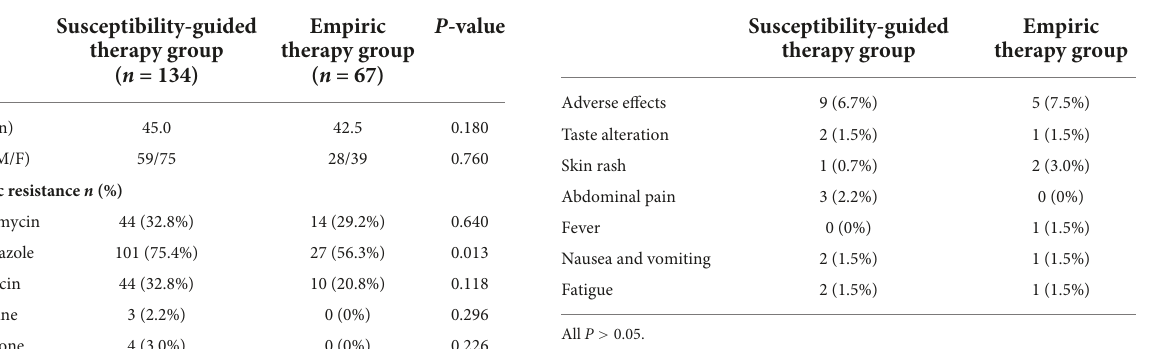
TABLE 1 Baseline characteristics of the included patients. TABLE 3 Adverse effects of the included patients.